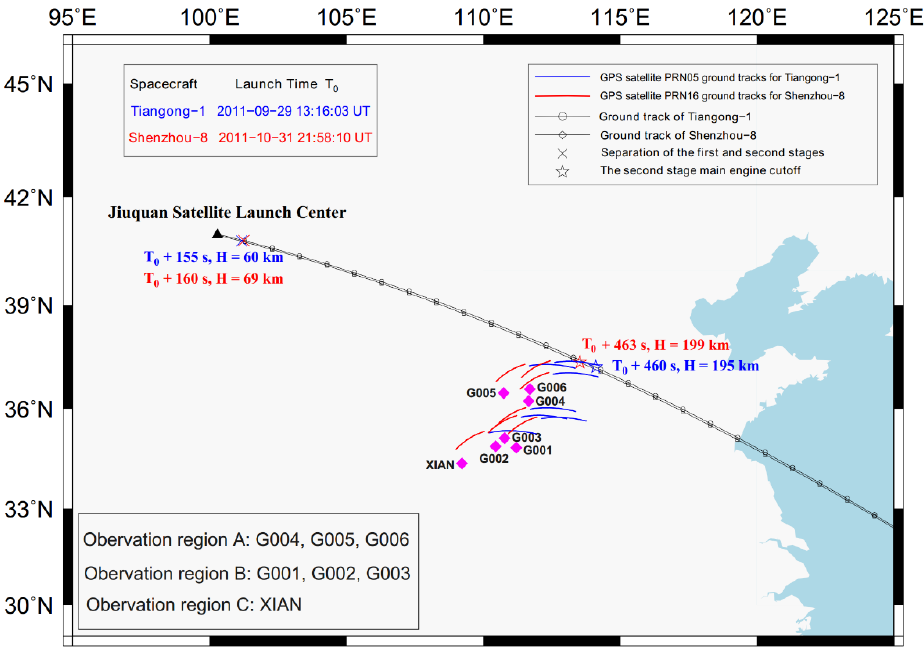
Figure 1. The observational geometry during the launches of Tiangong-1 and Shenzhou-8 from Jiuquan Satellite Launch Center. The Tiangong-1 and Shenzhou-8 launch track over ground is indicated. The black triangle shows the location of the JSLC. The blue and red crosses represent the locations of Tiangong-1 and Shenzhou-8 at the moment of the separation of the first and second stages of the rock- ets, respectively. The blue and red pentacles denote the locations of Tiangong-1 and Shenzhou-8 at the moment of the main engine cutoff at the second stage, respectively. The pink diamonds mark seven GPS stations used in this study including observation region A (G004, G005, G006), observation region B (G001, G002 G003) and observation region C (XIAN). The blue and red lines show the trajectories